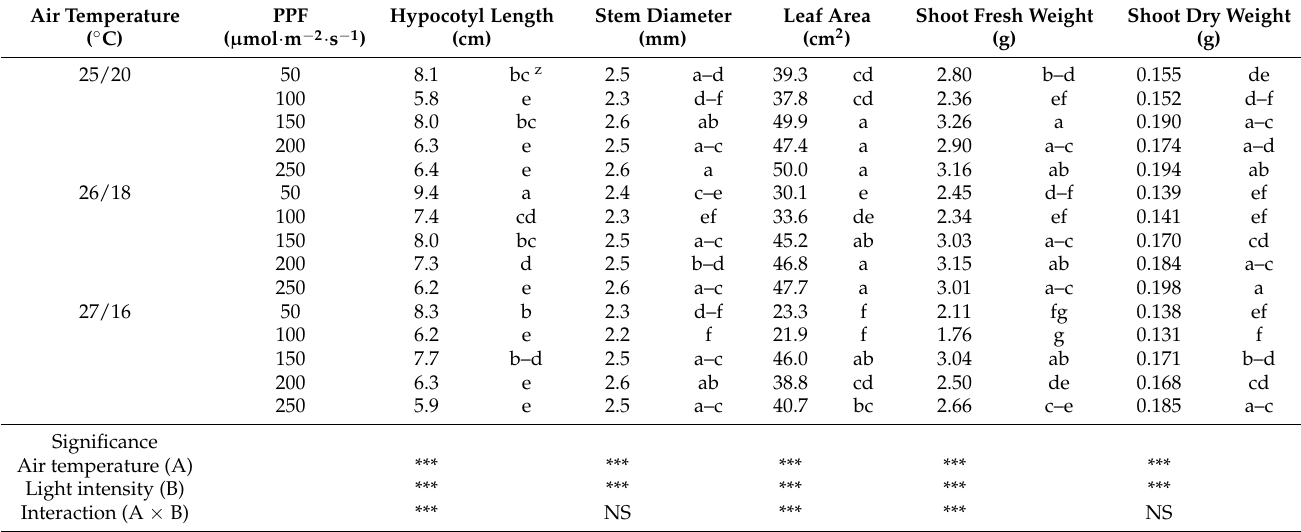
Table 2. Growth of cucumber rootstocks as affected by the different air temperature and light intensity at 6 days after cultivation in a PFAL.